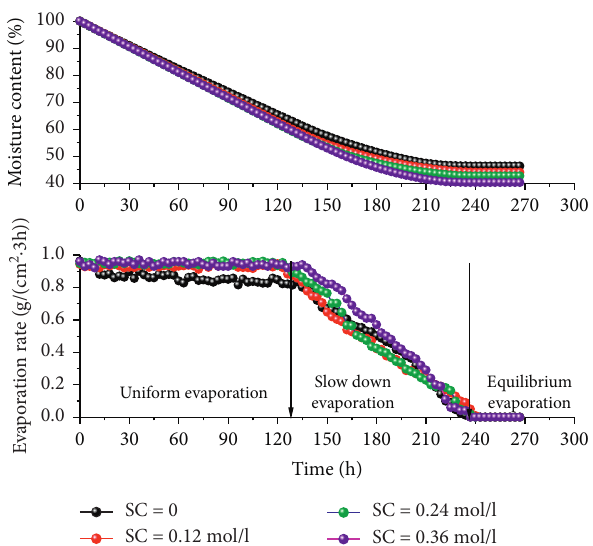
Figure 2: Moisture content and evaporation rate varying with drying time under different saline